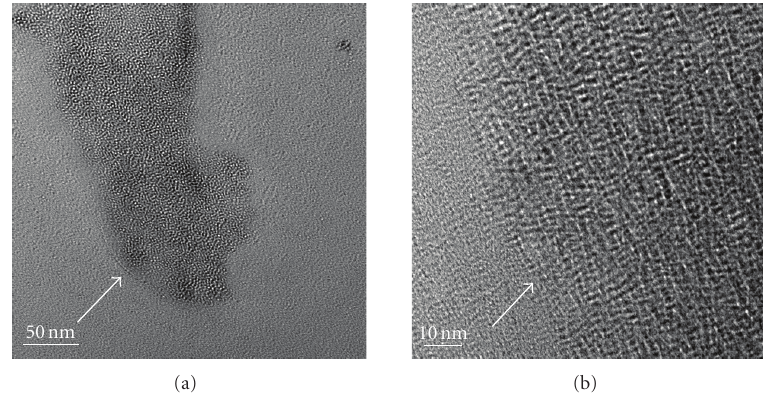
Figure 3: TEM (a) and HRTEM (b) of Ru nanoparticles in aqueous colloid; the arrows denote the same